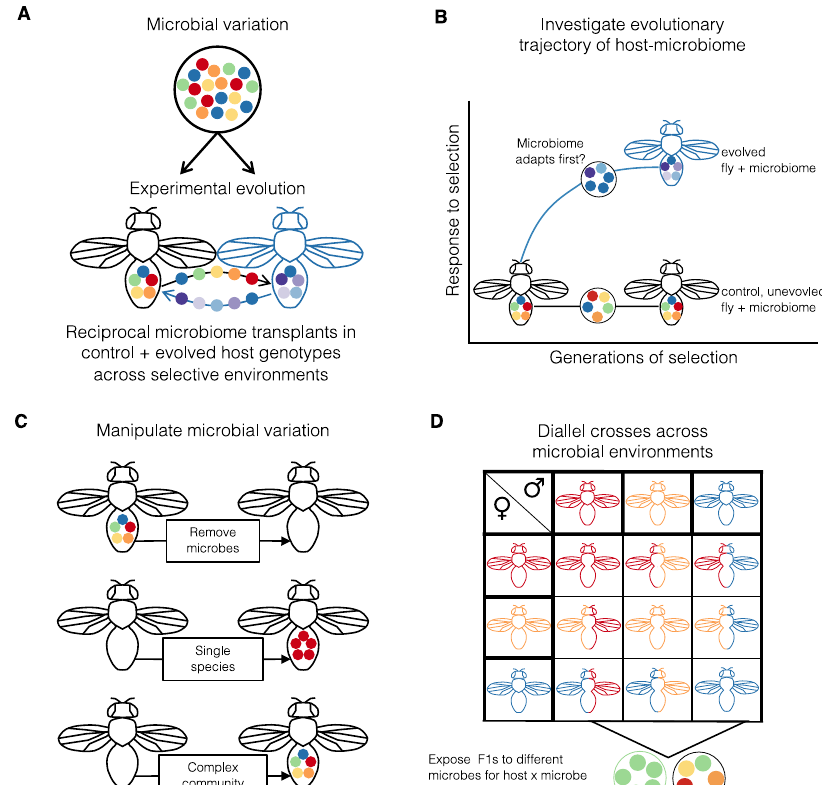
Fig. 3 Partitioning microbial effects on host adaptation. Experimental approaches developed for variance partitioning in quantitative genetics can be a powerful way to assess the in fl uence of the microbiome on host evolution. A Experimental evolution will provide critical insights into how hosts and microbiomes respond to stressful environments. By including the microbiome (visualized as different colored circles) in experimental evolution, then genetic responses in both host and microbiome can be measured following selection. At the end of experimental evolution, we expect both host and microbiome to adapt - visualized as blue fl y and blue/purple microbes. Microbial evolution may occur at the strain level (e.g., when bene fi cial mutations in particular genes drive adaptation to the novel selective pressure). Alternatively, selection may increase the frequency of a particular microbial taxon, leading to loss of microbial taxa in the adapted microbiome. To test how the microbiome interacts with the host genome to in fl uence host phenotypes, one can perform fully factorial, reciprocal transplants between host, microbiome, and environment. B Key insights will be gained from examining the evolutionary trajectory of alleles that emerge or change in frequency during experimental evolution. C To test how microbial variation in fl uences host phenotype, hosts can be inoculated with different levels of microbial variation. Removing the microbiome through antibiotics (or other manipulations) will show how hosts respond to perturbation to their microbiomes. D Finally, diallel crosses can be used to show how host and microbial genetic variation interact. Diallel crosses are performed by crossing all possible combinations between inbred lines to each other in a common environment (represented by fl y colors). Rearing F1s in different microbial environments will enable partitioning of the additive and nonlinear, epistatic components between host and microbial genetic